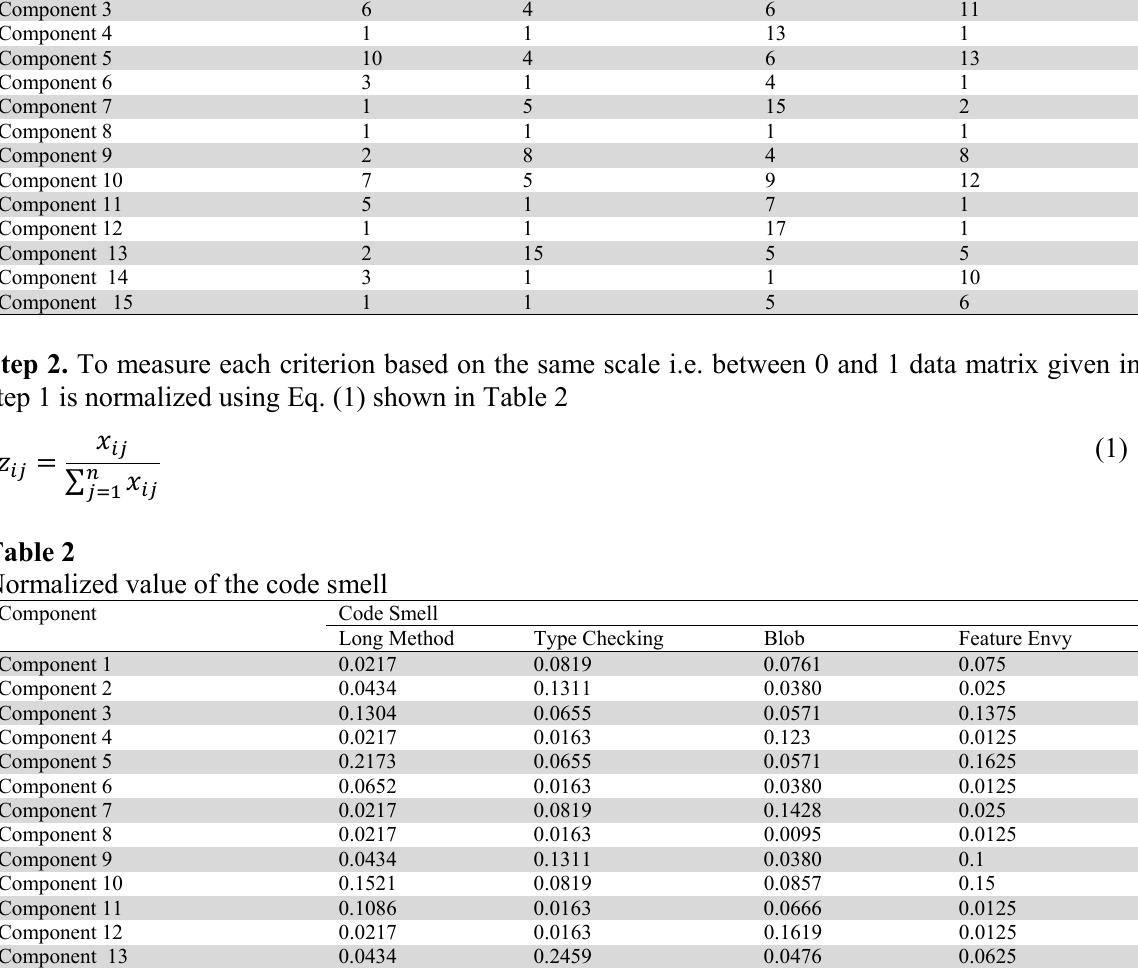
Matrix contains the value of the code smell detected by the tool Jdeodorant Component Code Smell Long Method Type Checking Blob Component 1